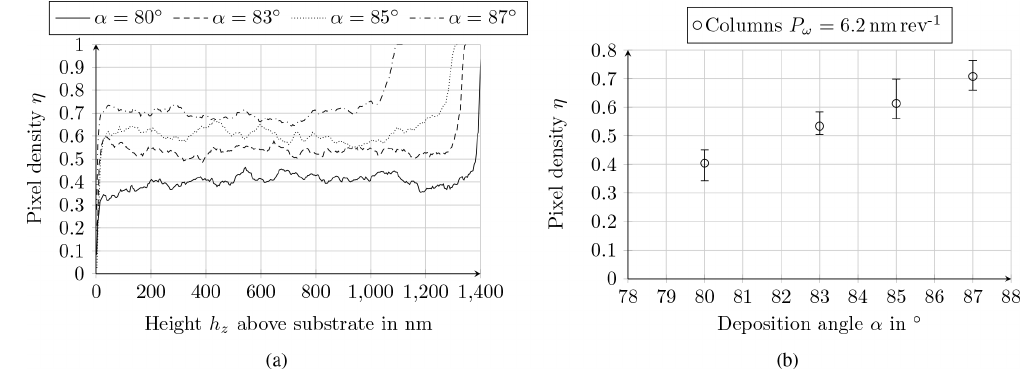
Figure 8. Pixel density profiles across the layer thickness for column structures ( P ω = 6 . 2nm per revolution) at different deposition angles as a function of (a) height h z above the substrate and (b) deposition angle α . The bars indicate the variation along the height coordinate of the layer, with 95% of the η values lying within the